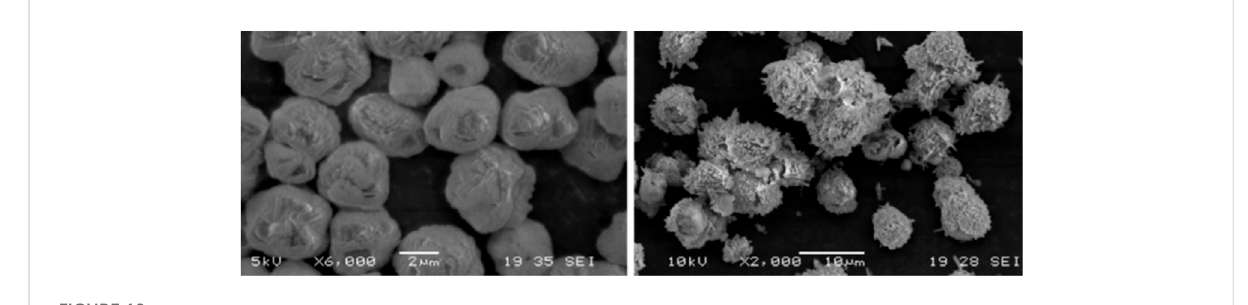
FIGURE 10 SEM microimages of vaterite calcium carbonate microspheres before and after Pb +2 removal. Reproduced with permission from Lin et al.